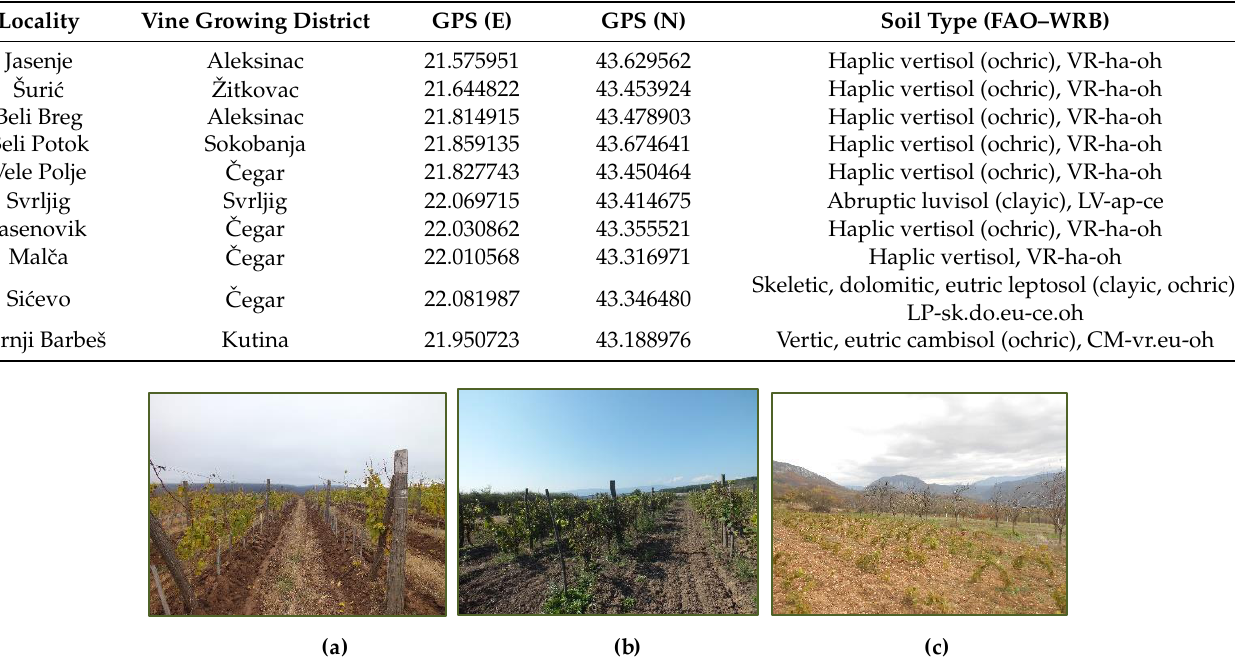
Figure 5. Some localities of the vine-growing region of Niš: ( a ) Svrljig—abruptic luvisol (clayic), LV-ap-ce; ( b ) Beli Breg—haplic vertisol (ochric), VR-ha-oh; ( c ) Si´cevo—skeletic, dolomitic, eutric leptosol (clayic, ochric), LP-sk.do.eu-ce.oh.